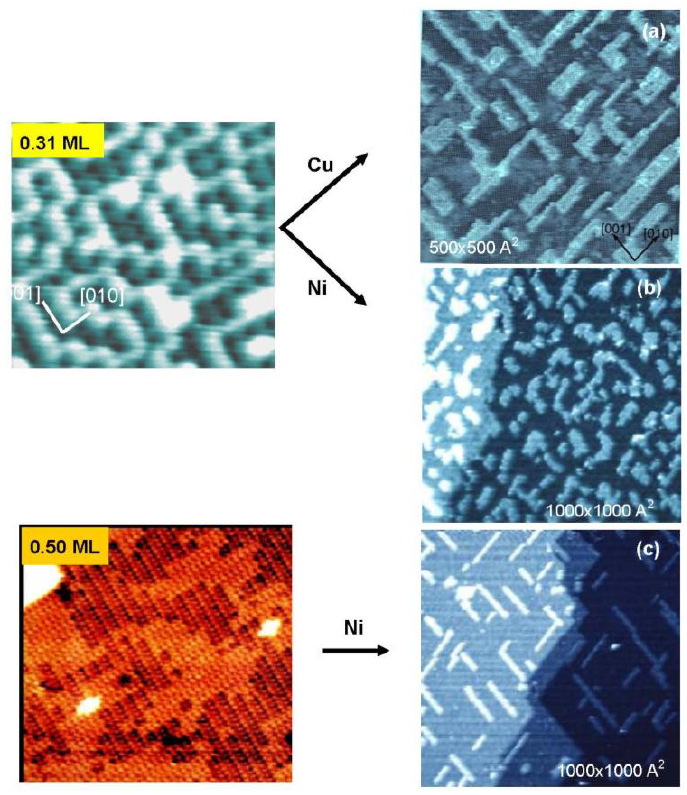
Figure 6. Surfactant growth of one atomic height ( a ) Cu layer and ( b ) Ni layer on a nano-c(2 × 2)-O Cu(100) surfaces [34,36]. The islands have rectangular shape of Cu-layer with Cu(100)-(2√2×√2)R45-O structure and non-oriented Ni-layer with Ni(100)-c(2 × 2)-O structure on a nano-c(2 × 2)-O Cu(100) surface; ( c ) Deposited Ni on on a Cu(100)-(2√2 × √2)R45-O surface grows in nano-width Ni-wires along the Cu atom missed